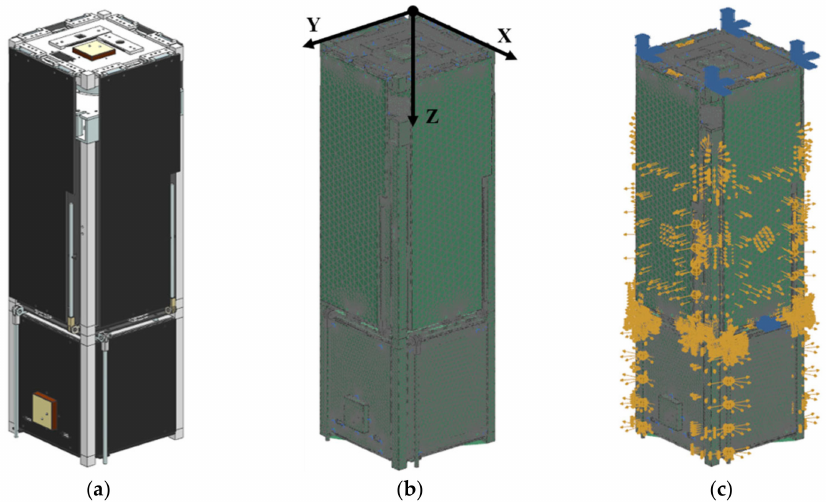
Figure 4. Models for the analyses: ( a ) Simplified CAD models of two CubeSats contained in the deployer;